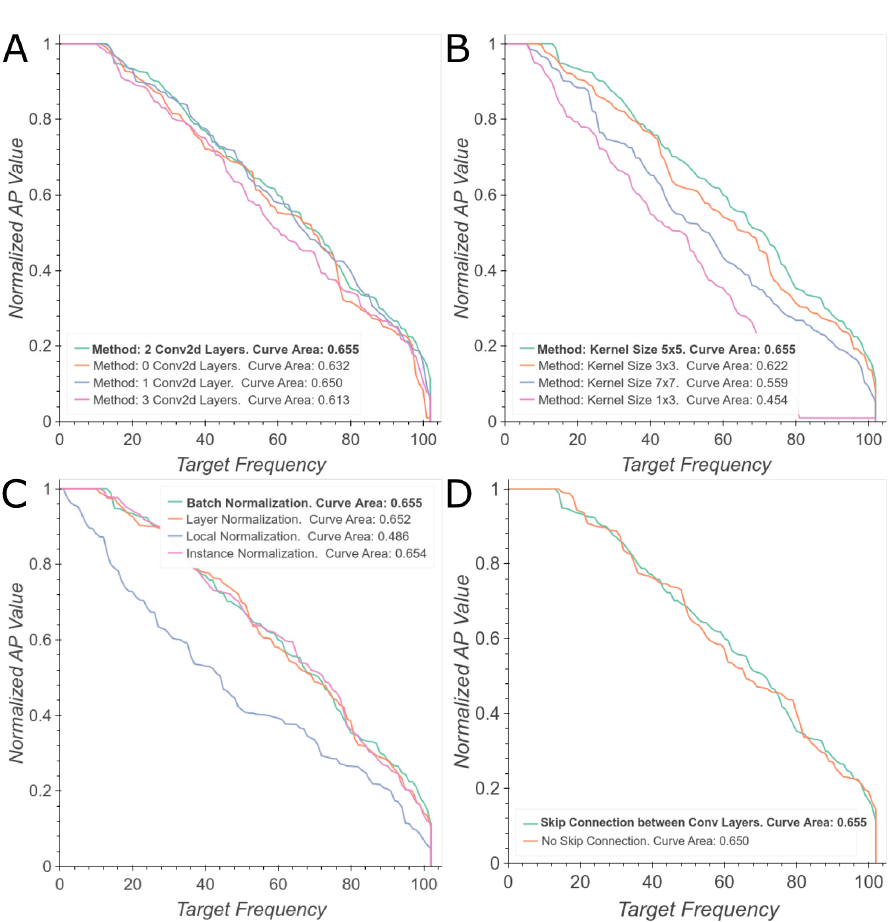
Fig 5. Ablation study of convolutional architecture. (A) Number of convolutional layers. (B) Kernel size for the convolution. (C) Type of normalization layers. (D) Type of residual connection. Best viewed in color.